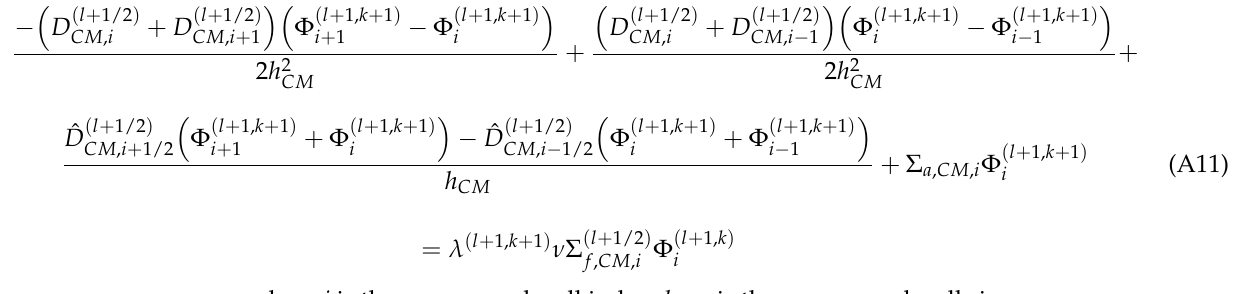
where i is the coarse-mesh cell index. h CM is the coarse-mesh cell